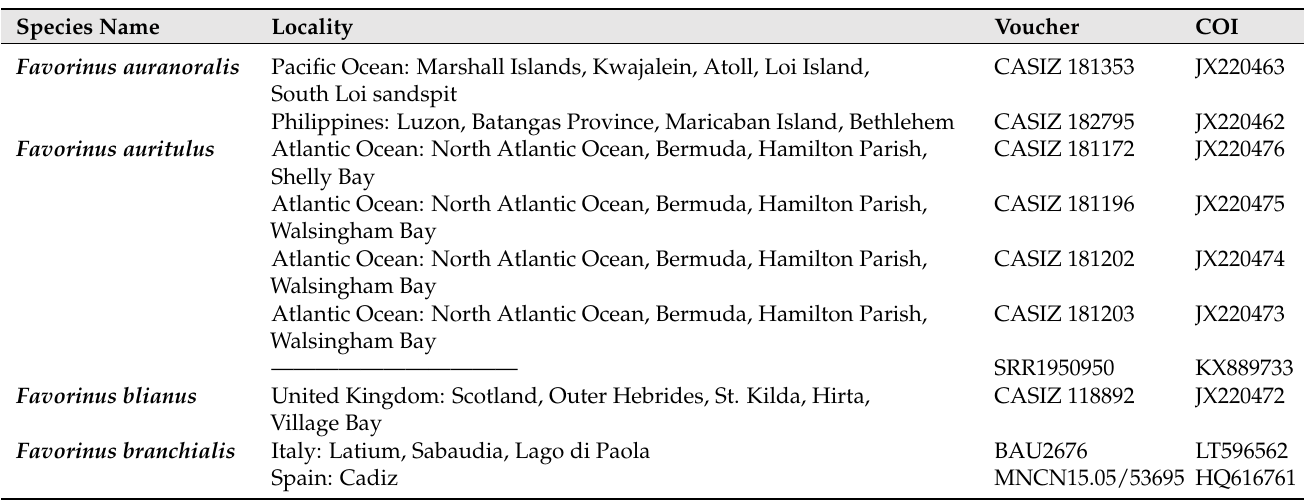
Table 2. Species names, collection localities, vouchers, and COI accession numbers of the specimens included in the molecular analyses. The ‘ * ’ symbol i ndicates the outgroups. In bold are the Ligurian specimens that were molecularly analyzed.